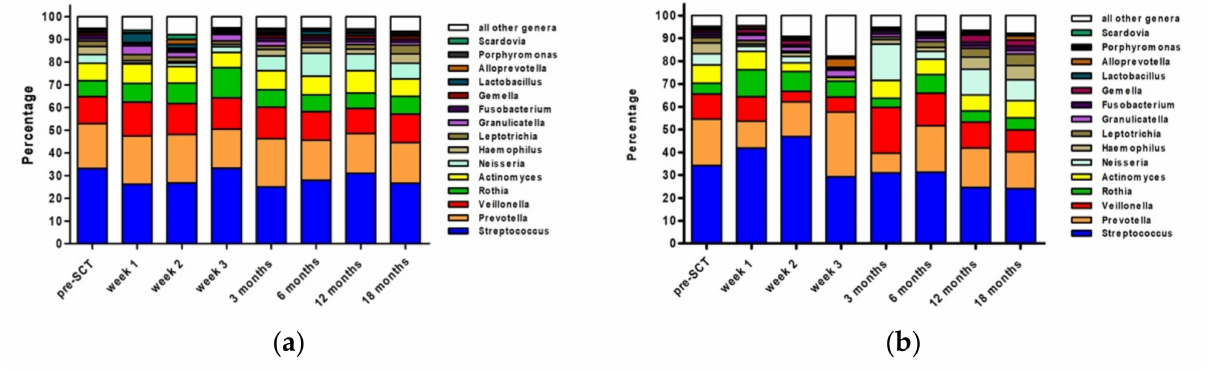
Figure 3. Relative Abundance (percentage) of top 15 most abundant genera at different time points in patients who did not experience oral mucositis ( a ) and patients who did experience oral mucositis ( b